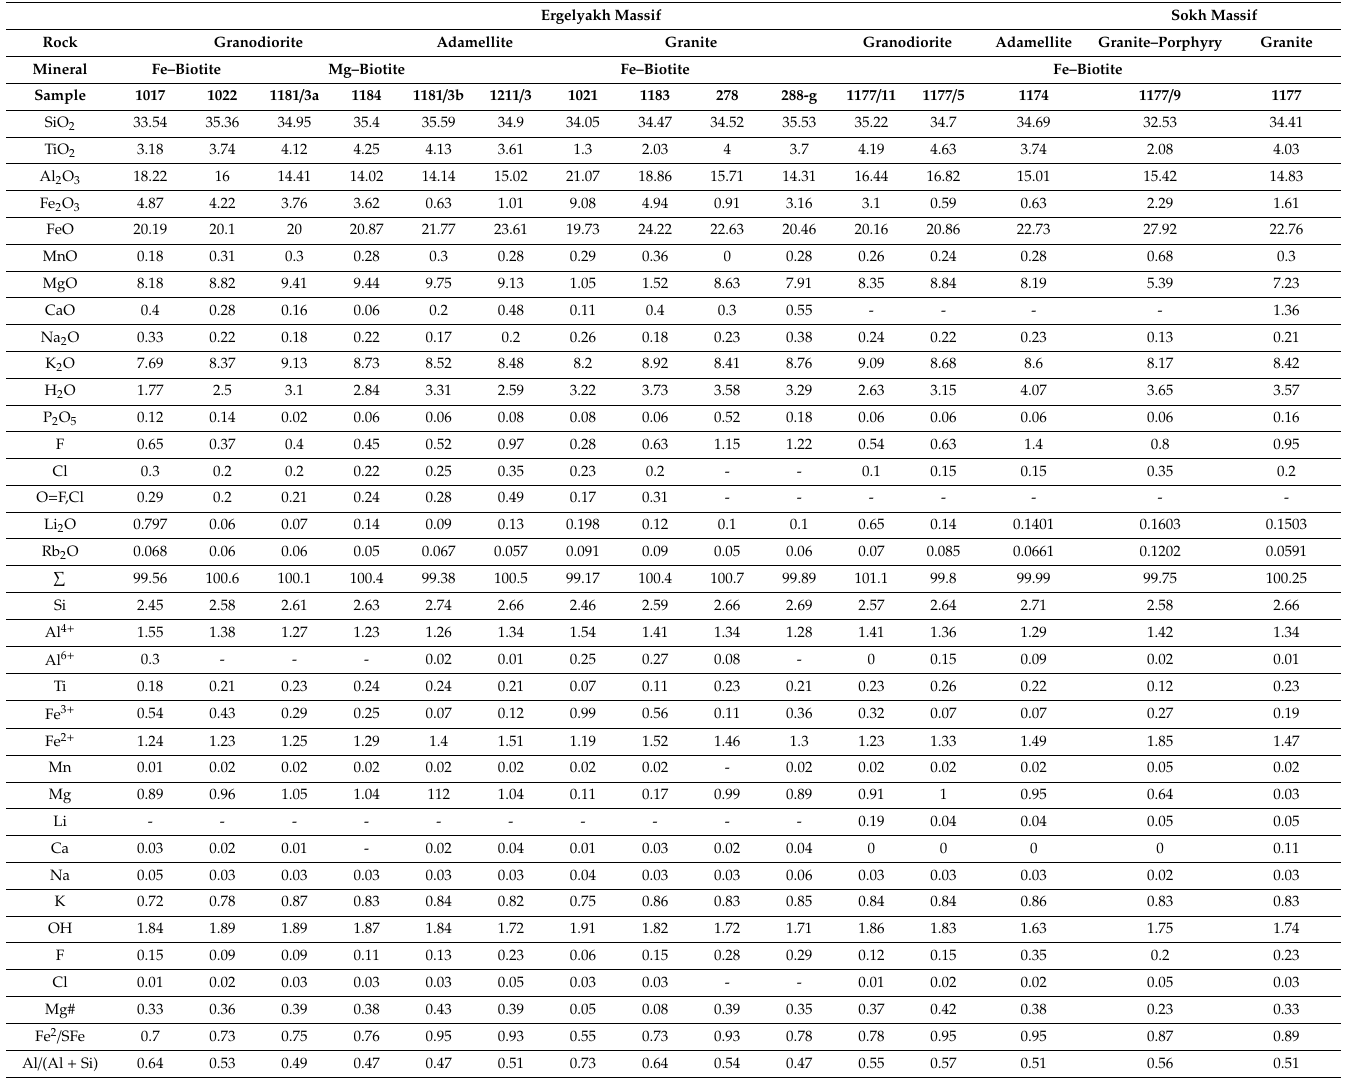
Table 3. Chemical analysis of biotite from Ergelyakh and Sokh